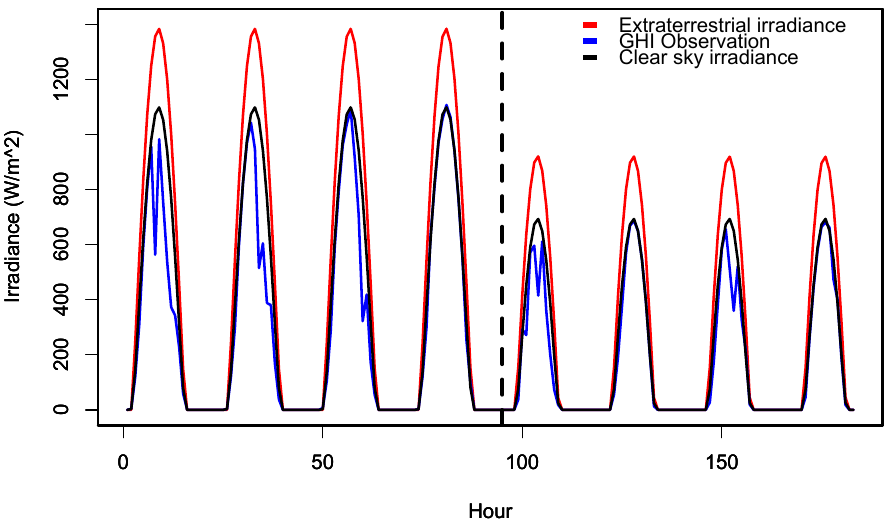
Figure 2. Measured GHI (SP site) vs. clear sky irradiance and extraterrestrial irradiance on hourly scale. The first four days correspond to the summer period, while the last four correspond to the austral